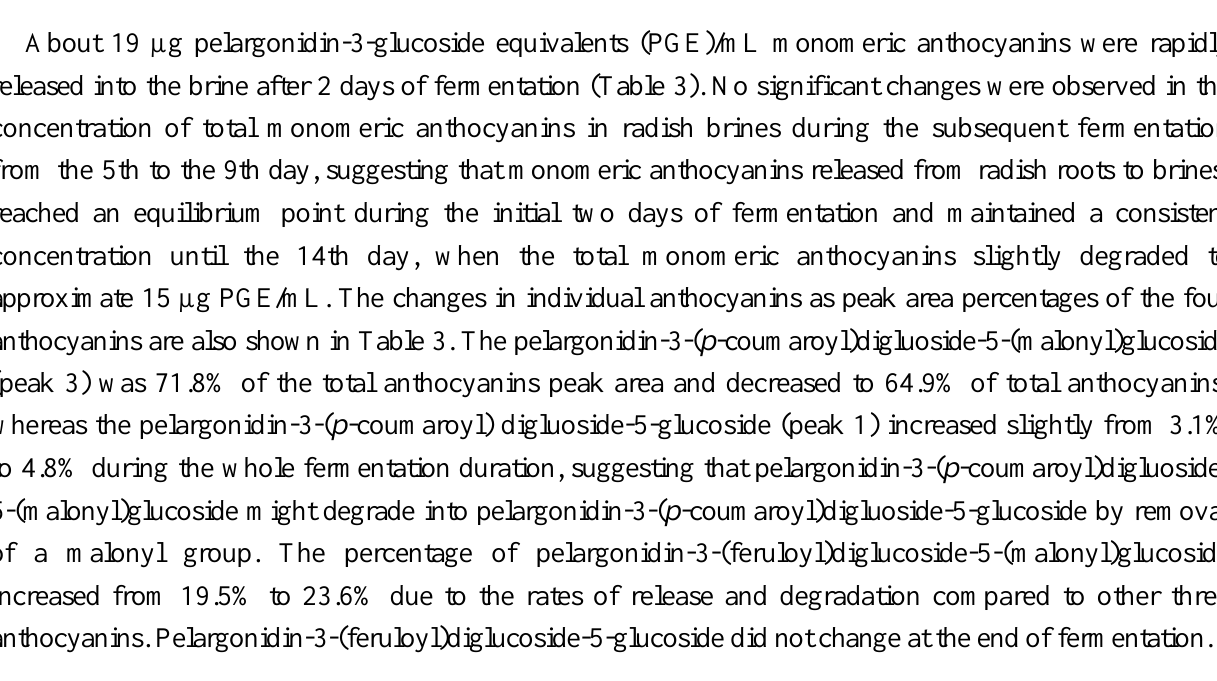
Table 3. Anthocyanins in radish brines during